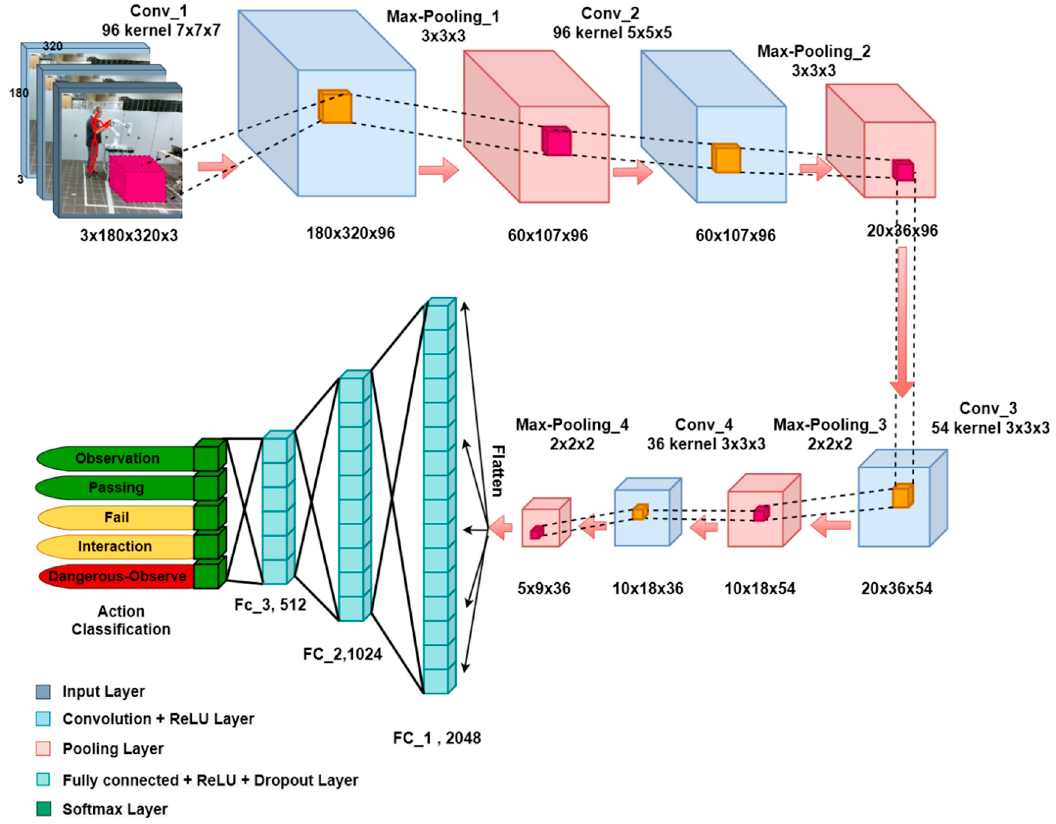
Figure 1. Three-dimensional convolutional neural networks (CNN) for human action recognition.